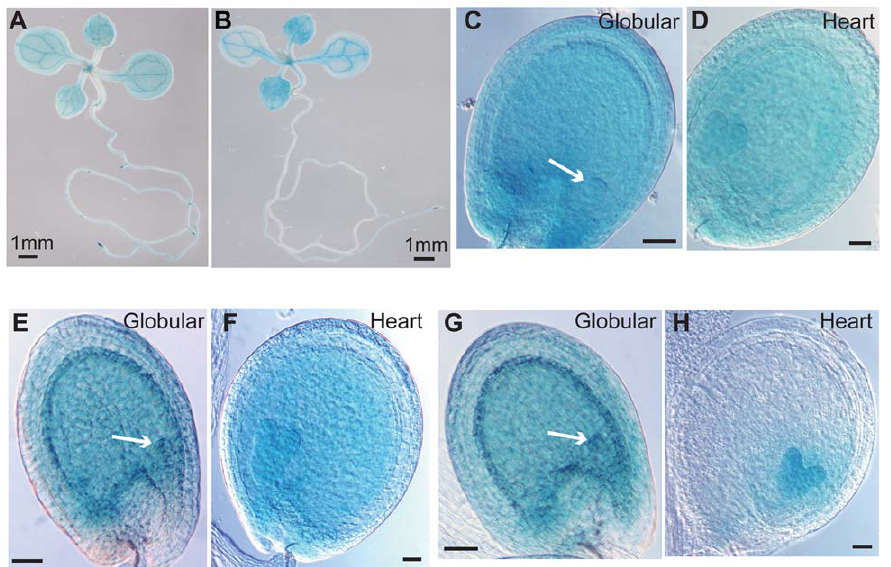
Figure 6. Spatial Expression Patterns of ASH2R , RBL , and WDR5a . (A–B) ASH2R-GUS (A) and RBL-GUS (B) expression in 1-week-old seedlings. (C– D) ASH2R-GUS expression in a representative seed with globular embryo indicated by an arrow (C), and with heart embryo (D). (E–F) RBL-GUS expression in a representative seed with globular embryo (E), and with heart embryo (F). (G–H) WDR5a-GUS expression in a representative seed with globular embryo (G), and with heart embryo (H). (C–H) Bars = 50 m m.